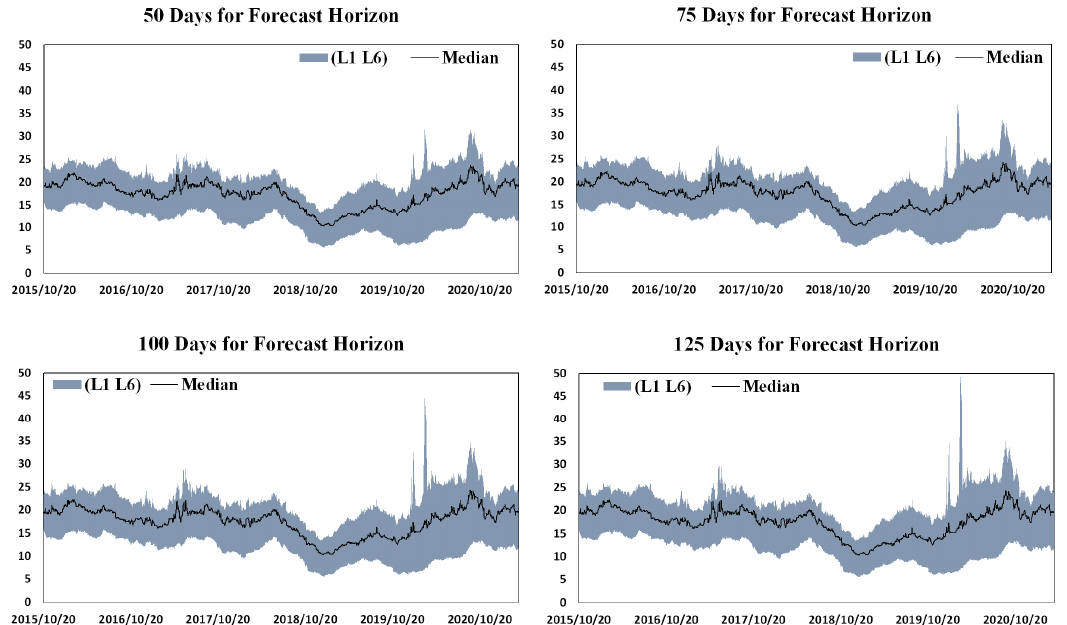
Figure 7. Total demand connectedness, error forecast horizons and VAR lags. Note: L1 and L6 individually represent the 1 and 6 lags for VAR system, and the median represents the medium lags during the range of 1 to 6, which is also the actual value selected in Sections 4.1 and 4.2.